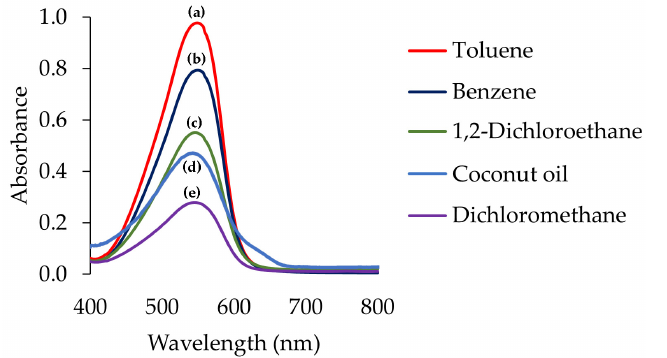
Figure 1. Visible spectra of Cu(II)-DPC complexes in solvents. Spectra: (a) toluene, (b) benzene, (c) 1,2-dichloroethane, (d) coconut oil, and (e) dichloromethane; for coconut oil, was normalized using OriginPro 2023 program (adjacent-averaging, points of window: